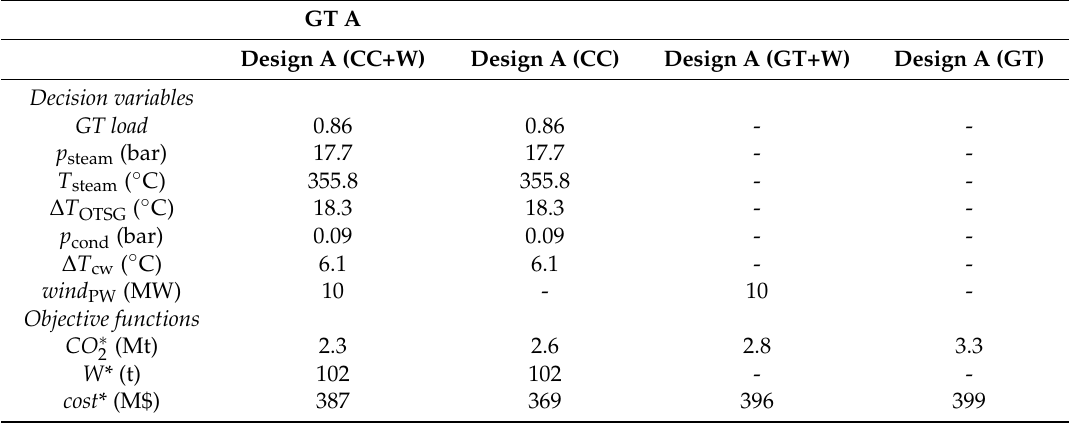
Table 4. Characteristics of the optimal designs selected based on a GT A.